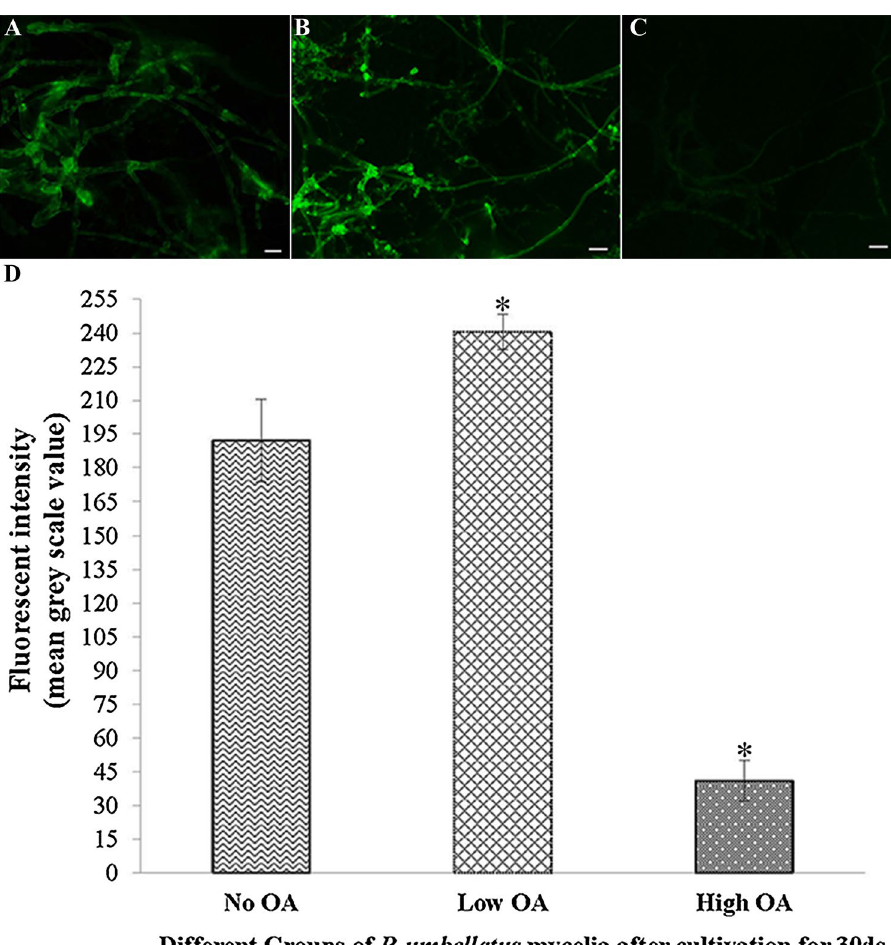
Figure 2. ROS content and fluorescence intensity of ROS in P. umbellatus mycelia affected by different concentrations of oxalic acid. After cultivation for 30 d, the ROS content of P. umbellatus mycelia in the No OA ( A ), Low OA ( B ) and High OA groups ( C ) is shown. Images are representative of three independent experiments (n = 30). Scale bar, 10 μm. The mean grey scale value of ROS in different groups of No OA, Low OA and High OA from three independent experiments is shown, with *standing for P < 0.05, compared to the control (No OA) group ( D